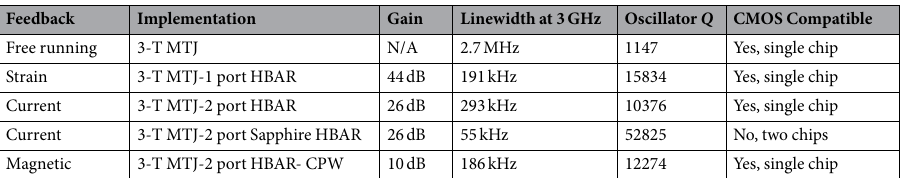
Table 1. Summary of results with a free running STNO and MASH oscillators implemented using different feedback methods. 3-T designates 3-Terminal devices. Gain column indicates the necessary amplitude for